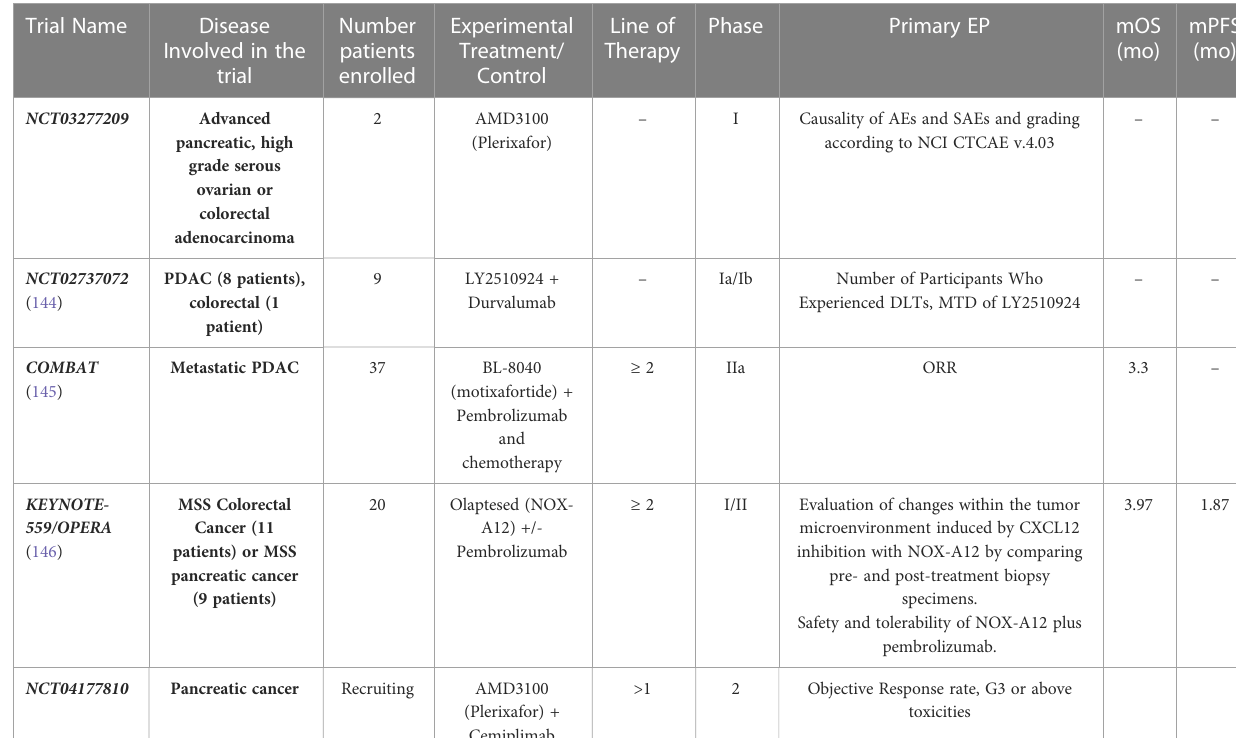
TABLE 2 Recruiting and completed trials of CXCL12-CXCR4-CXCR77 inhibitors plus immunotherapy in